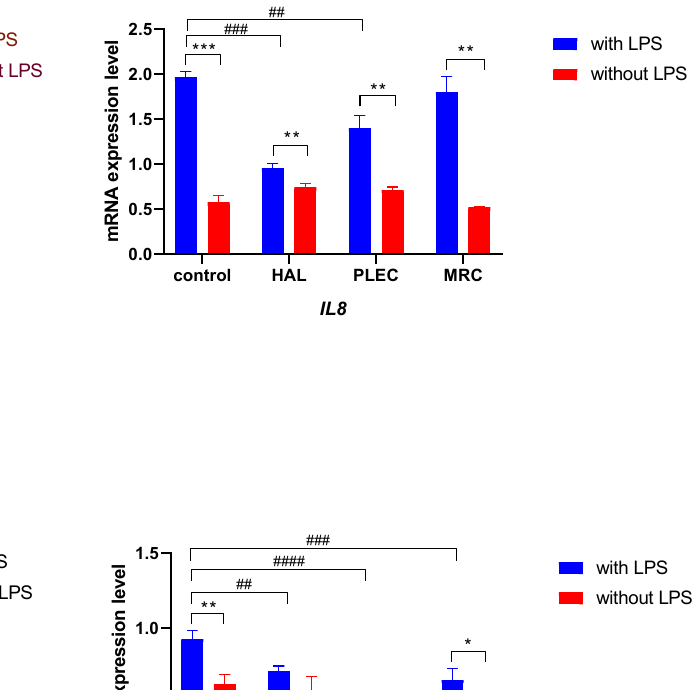
Table 1. Physicochemical properties, lipophilicity, solubility, bioavailability, and drug-likeness predictions for the plant-derived diterpenes and the positive control, gemcitabine.